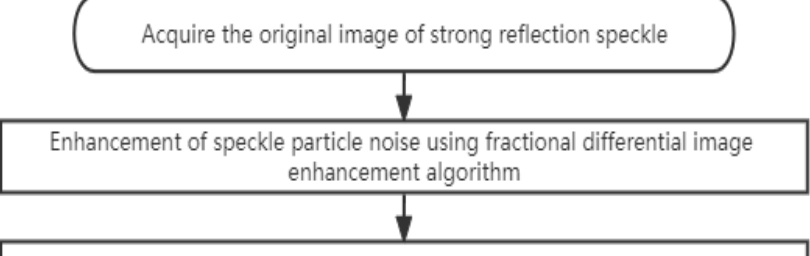
where G ( i , j ) is the gray value of row i and column j in the light bar image, and ( u j , v j ) is the gray value of the extracted light bar image coordinates of the heart.